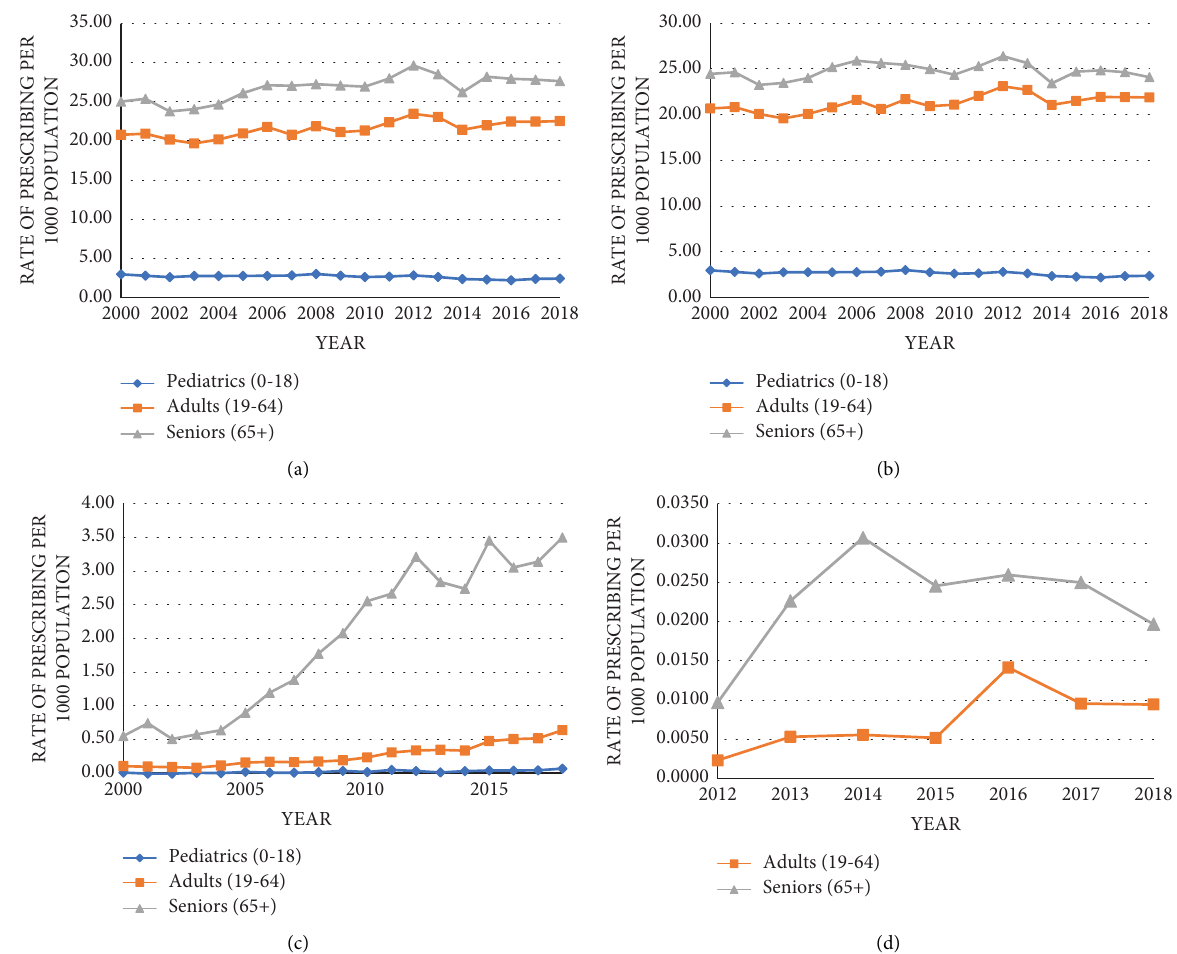
Figure 2: Rate of total oral CDI-indicated antibiotic prescribing and by individual antibiotic, stratifed by age categories (pediatric: 0–18; adult:19–64; senior: > 65), in British Columbia, 2000–18: (a) shows the rate of total antibiotic prescribing for each age group; (b–d) show the rate of rate prescribing for metronidazole, vancomycin, and fdaxomicin, respectively, for each age